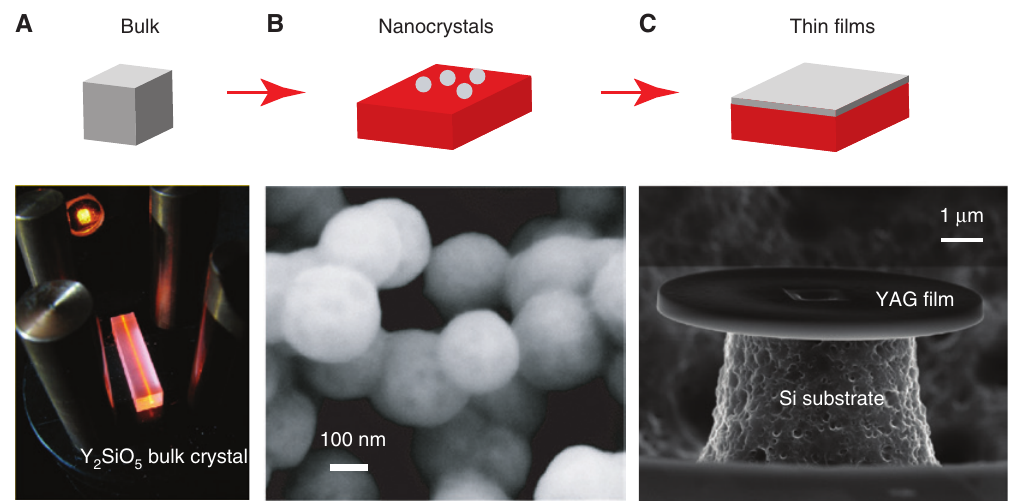
Figure 1: Evolving material platforms for rare-earth quantum devices from (A) macroscopic bulk crystals (reprinted from [11]) to low- dimensional materials including (B) doped nanocrystals (reprinted from [63]) and (C) sub-micron thick YAG films fabricated by smart-cut and thermal exfoliation (unpublished work from T.